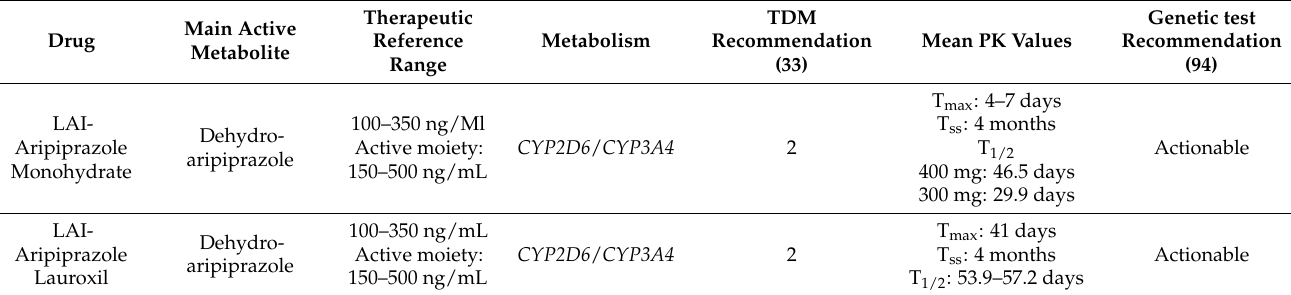
Table 8. Summary of PK/PG characteristics of